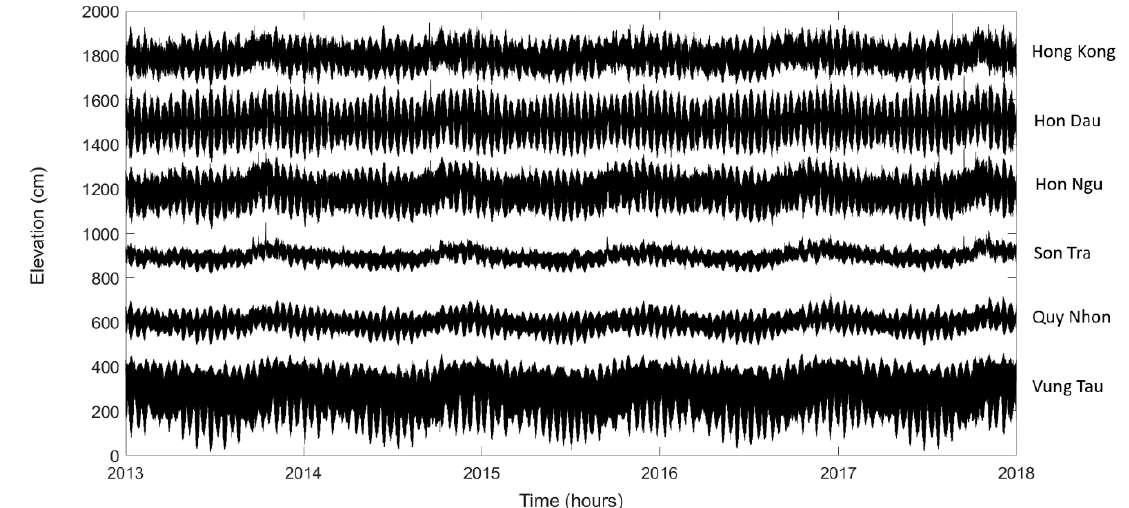
Figure 5. Observed water level time series at all stations. Note that each time is displaced by 300 cm.